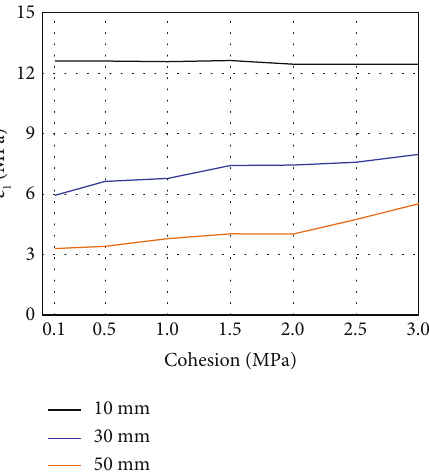
Figure 12: Peak strain of limestone grouting reinforcement bodies under di ff erent crack lengths and di ff erent bonding cohesion values of grouting stone